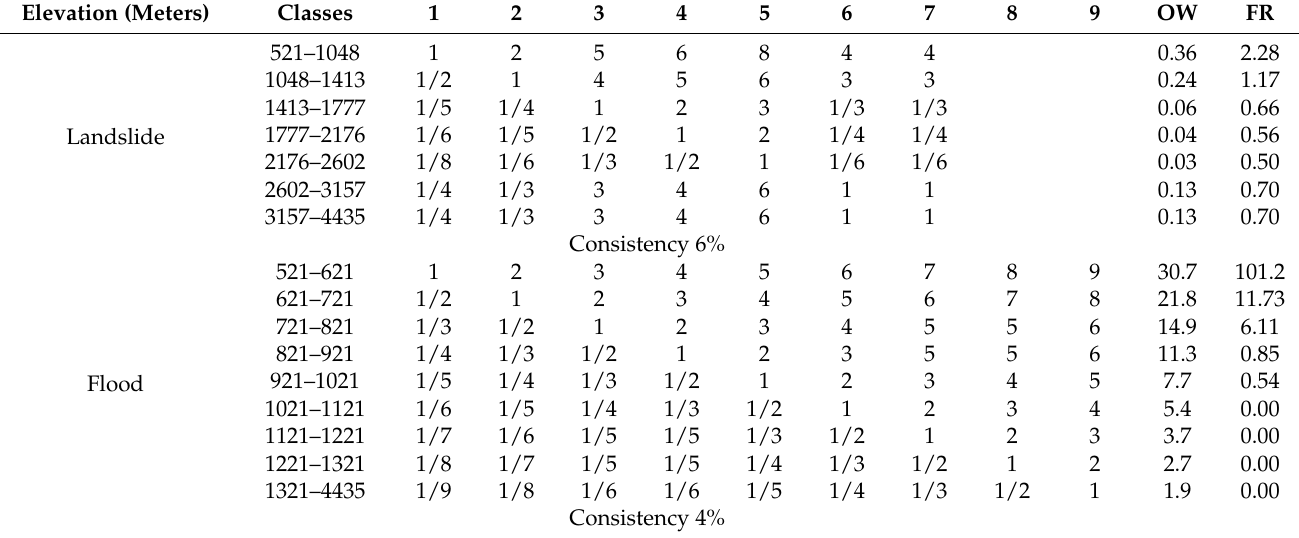
Table 5. AHP matrices and OWs for the elevation causative factor